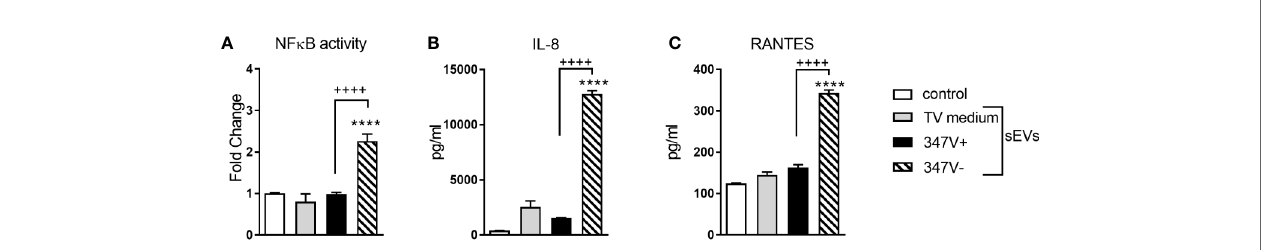
FIGURE 1 | TVV infection status modi fi es the immunostimulatory properties of TV sEVs in bystander cervical cells. Endocervical cells were treated with control no sEV, sEVs derived from TV medium alone, 347V+, or 347V- for 24 h. (A) NFkB activity was measured by a luciferase reporter assay and shown as fold change from control. (B) IL-8 and (C) RANTES protein levels by MSD assays. Data represent two independent experiments performed in triplicate and plotted as mean ± standard deviation. ****p < 0.0001 represent sEVs different from control. ++++ p < 0.0001 represent 347V- different from